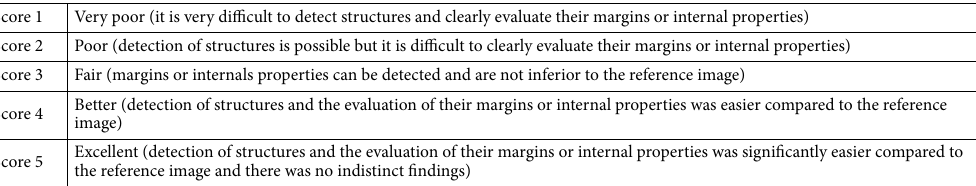
Table 2. Scoring for overall image